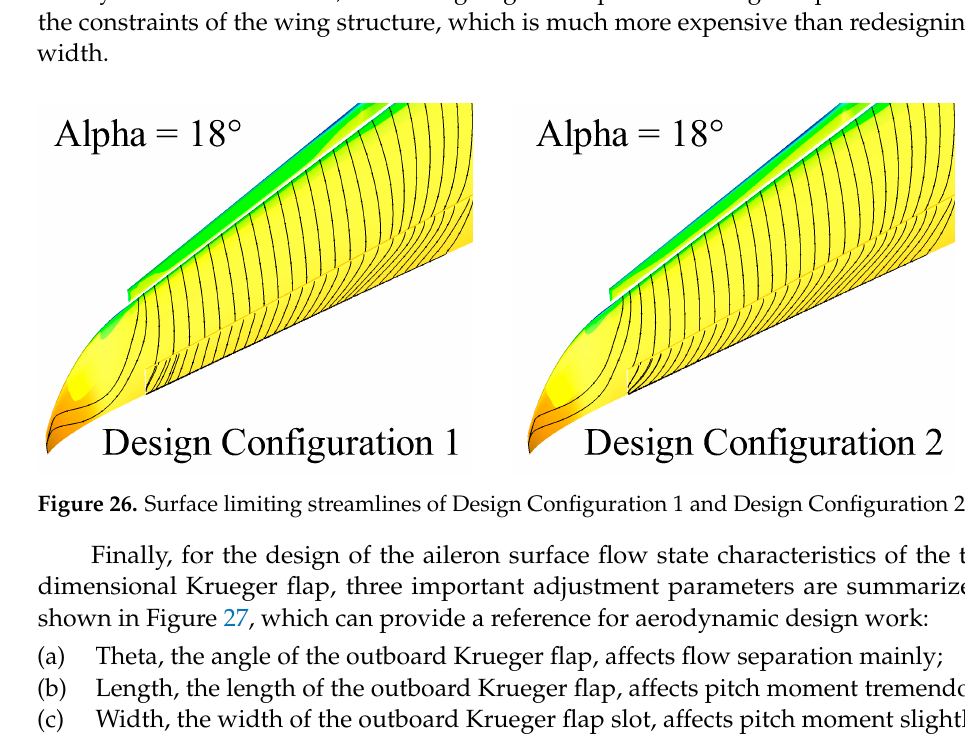
Figure 26. Surface limiting streamlines of Design Configuration 1 and Design Configuration 2.